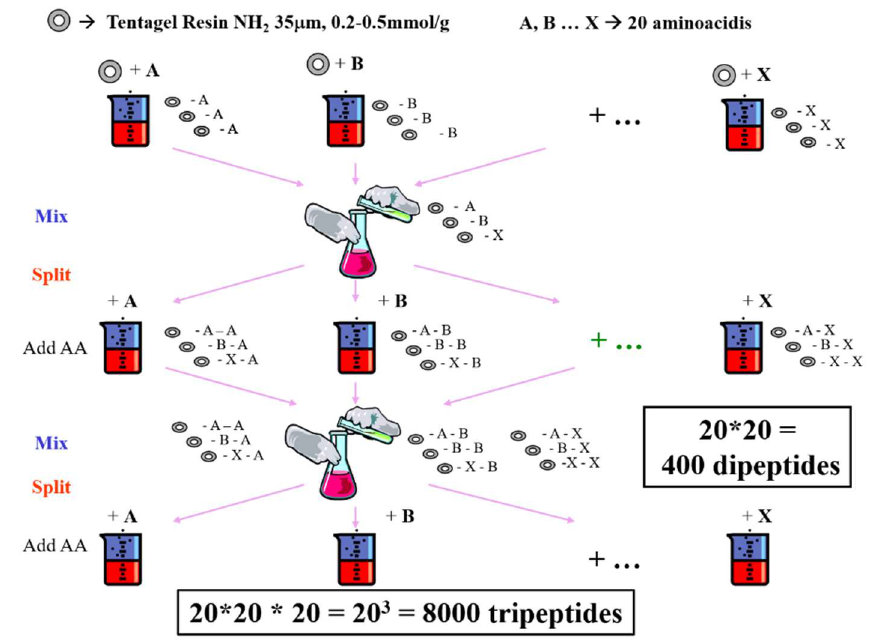
Figure 2. Schematic illustration of split–and–mix combinatorial synthesis.